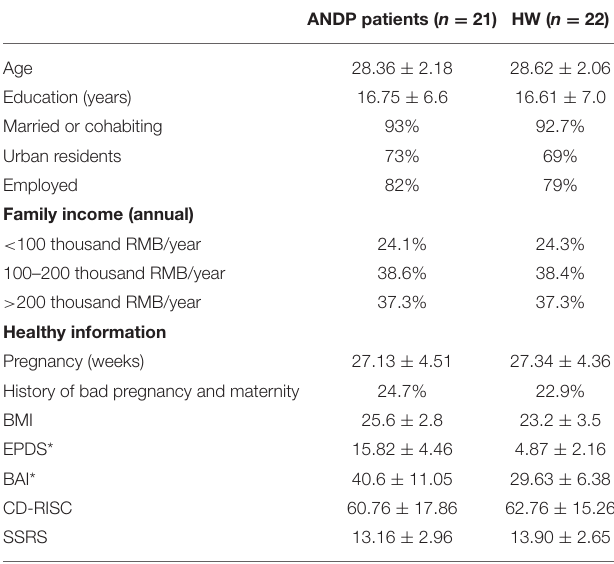
TABLE 1 | Demographic